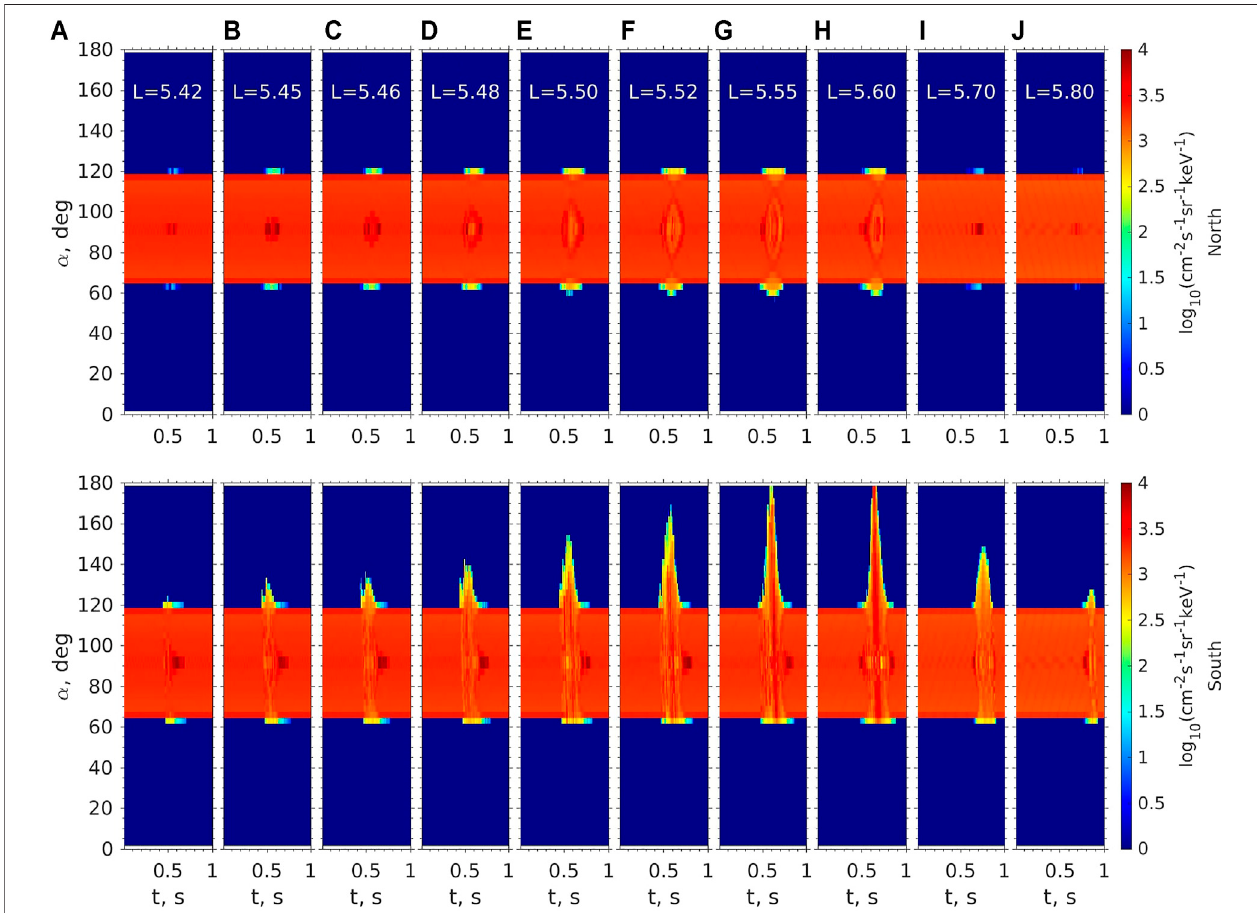
FIGURE 8 | Modeled pitch angle distribution of electron fl uxes for a fi xed energy 70 keV at virtual northern (top panels) and southern (bottom panels) LEO satellites due to the presence of the nonducted wave shown in Figure 5 at selected fi eld lines with L values from 5.42 to 5.80 (A – J) .